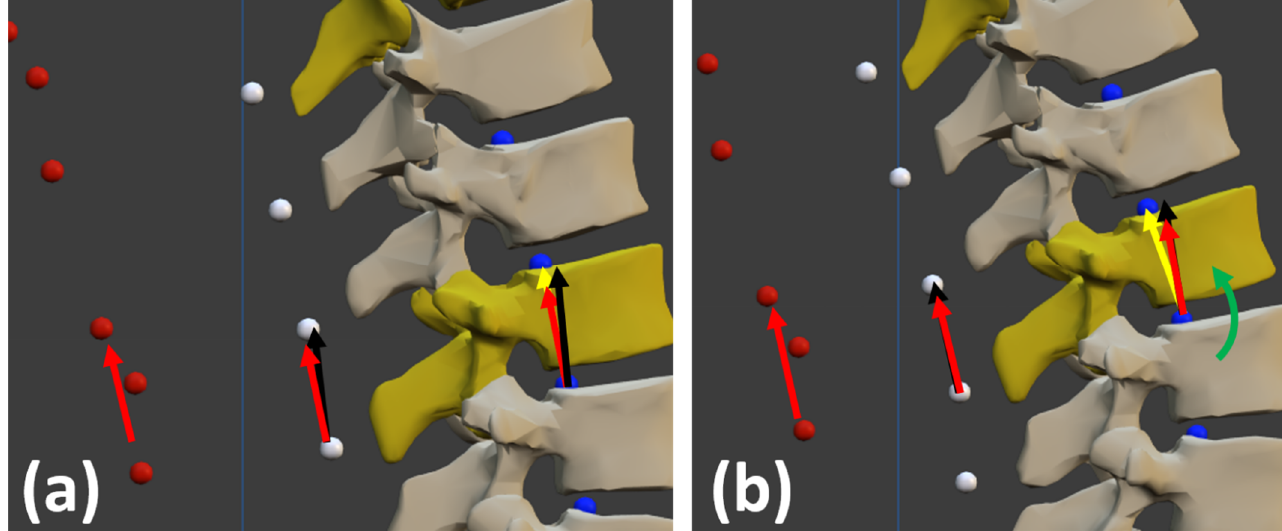
Figure 6. ( a ) Angular offset between the orientation measured by the sensor (red vectors) and the external segments defined by the estimated external surface of the back (black vectors); ( b ) Angular offset and corrected body orientation (yellow vector) by rotation (green arrow).